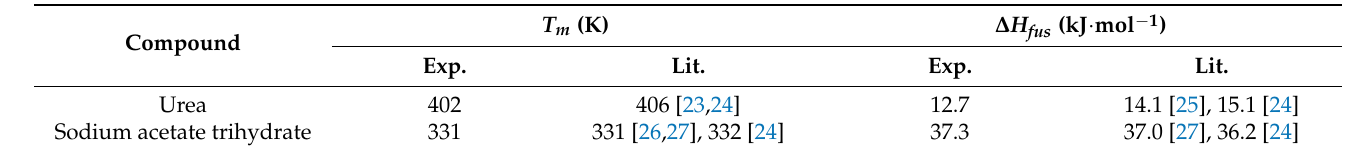
Table 1. Melting temperature ( T m ) and enthalpy of fusion ( ∆ H fus ) of the eutectic compounds. “Exp.” refers to experimentally determined values, and “Lit.” refers to literature values.